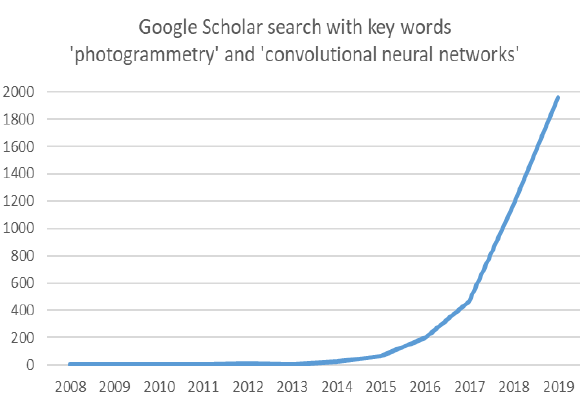
Figure 1. The annual number of photogrammetric publications utilizing convolutional neural networks reveals the popularity of the